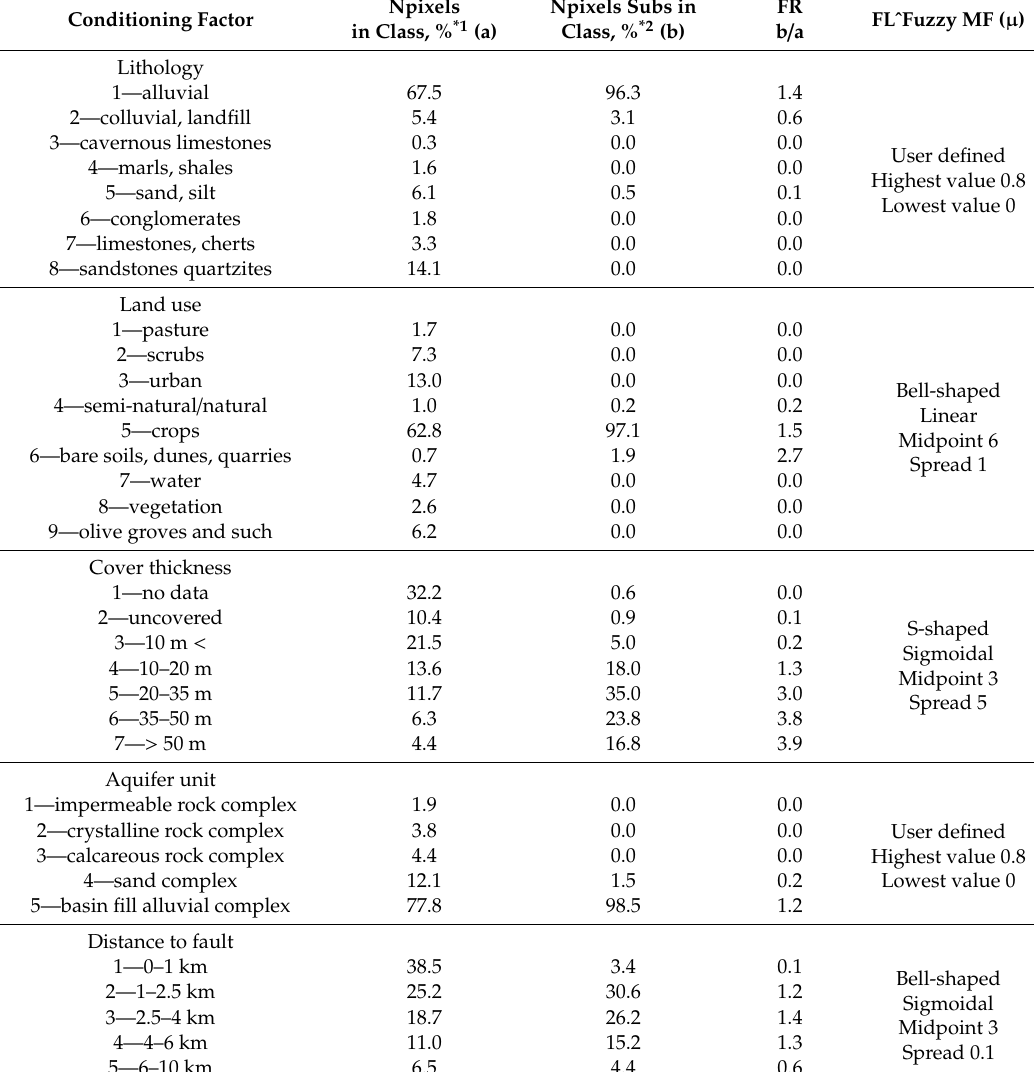
Table A2. Predisposing factors, their classifications, pixel computations, FR and FL assessment for recent subsidence inventory (2014–2019) derived from SENTINEL-1 PS